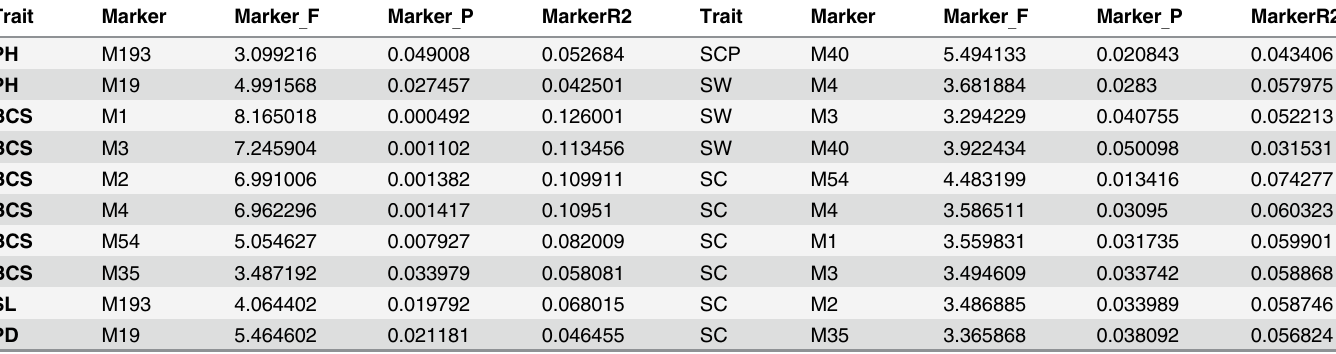
Table 3. Association of SSR markers with percentage of reduction of complex agronomic traits of tall fescue accessions by corrected P values ( P < 3.5×10 − 4 ). Trait